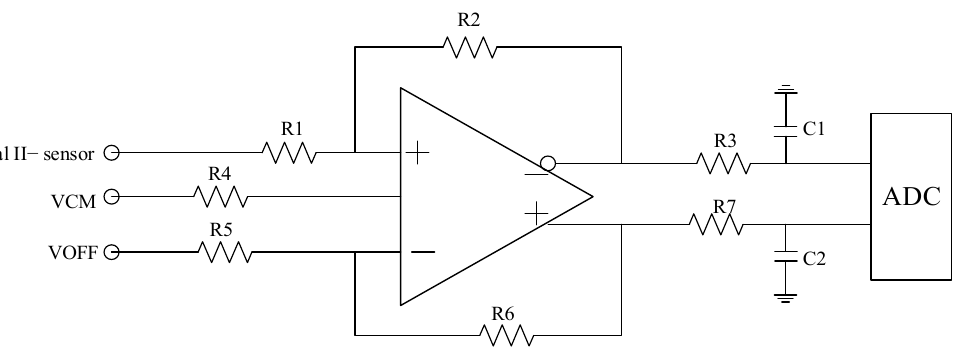
Figure 7. The analog buffer circuits.